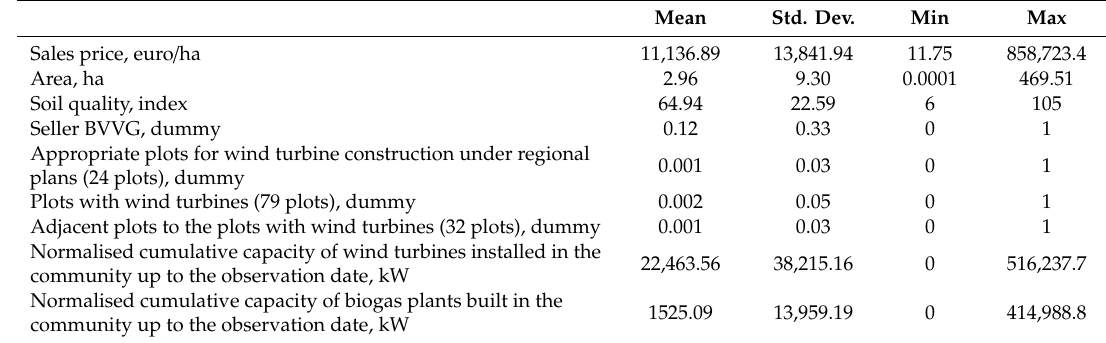
Table 3. Descriptive statistics for the transaction-based model ( N =